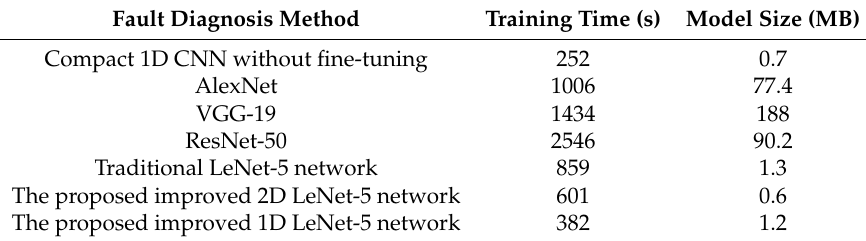
Figure 13. Accuracy comparison of different fault diagnosis methods. Table 9. Training time and model size comparison of different fault diagnosis